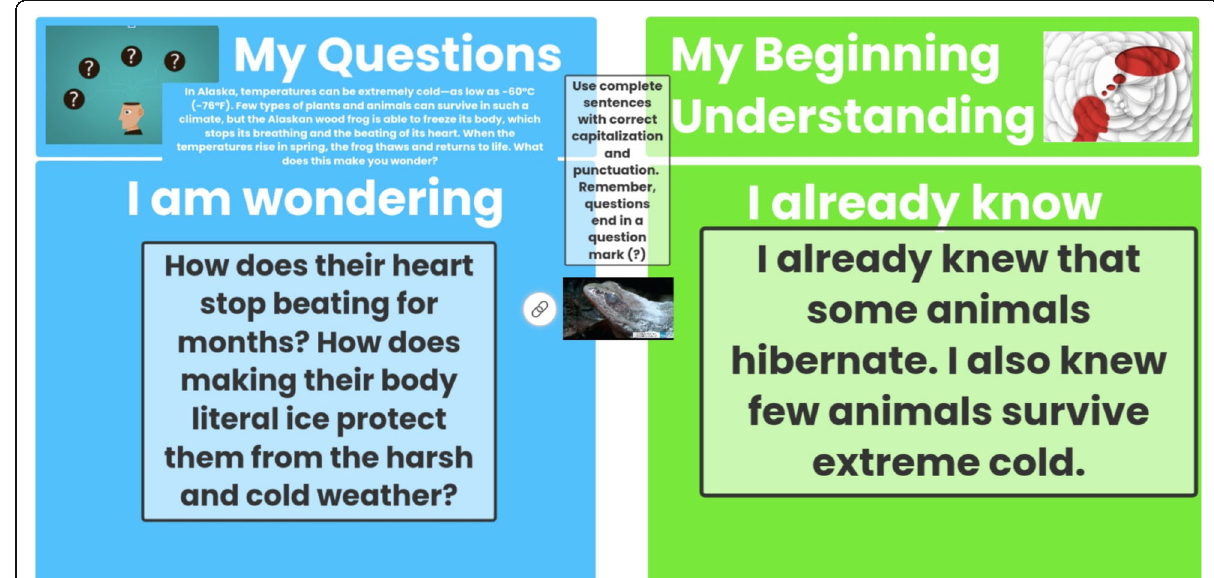
Fig. 3 A Screenshot of Students ’ Questions from LR ’ s Class